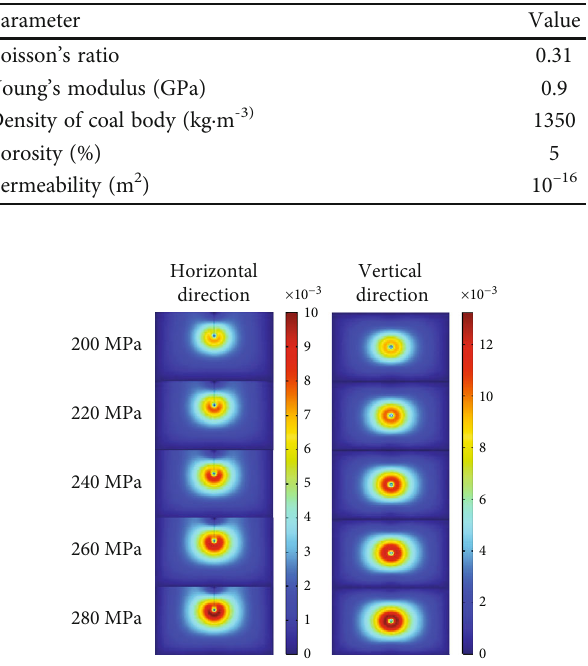
Figure 5: Displacement cloud of coal body under di ff erent blasting pressures.